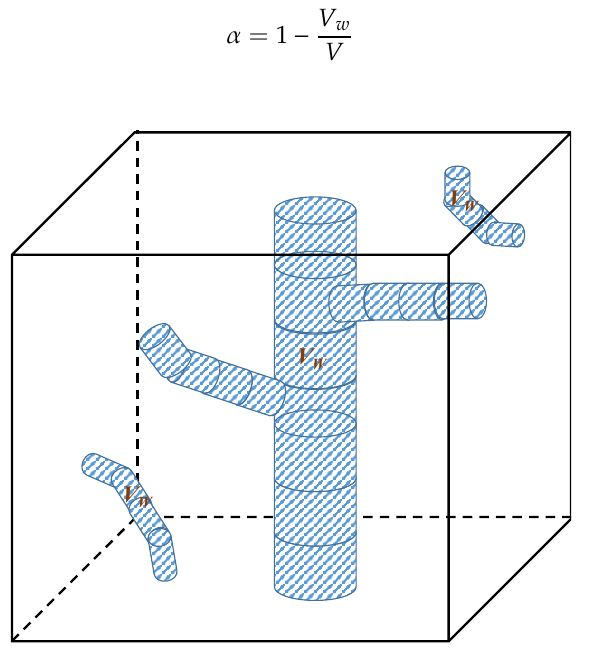
Figure 2. Scheme of the representation of wood volumes 𝑉 𝑤 (in dashed blue) in the voxel of volume 𝑉 . We assume that leaf elements are randomly distributed in volume 𝑉 − 𝑉 𝑤 , which exhibits a very complex and unknown topology.